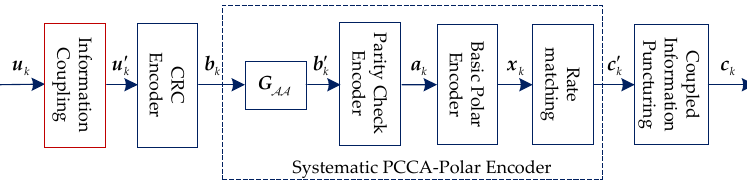
Figure 6. Partially information-coupled (PIC) PCCA-polar encoder.